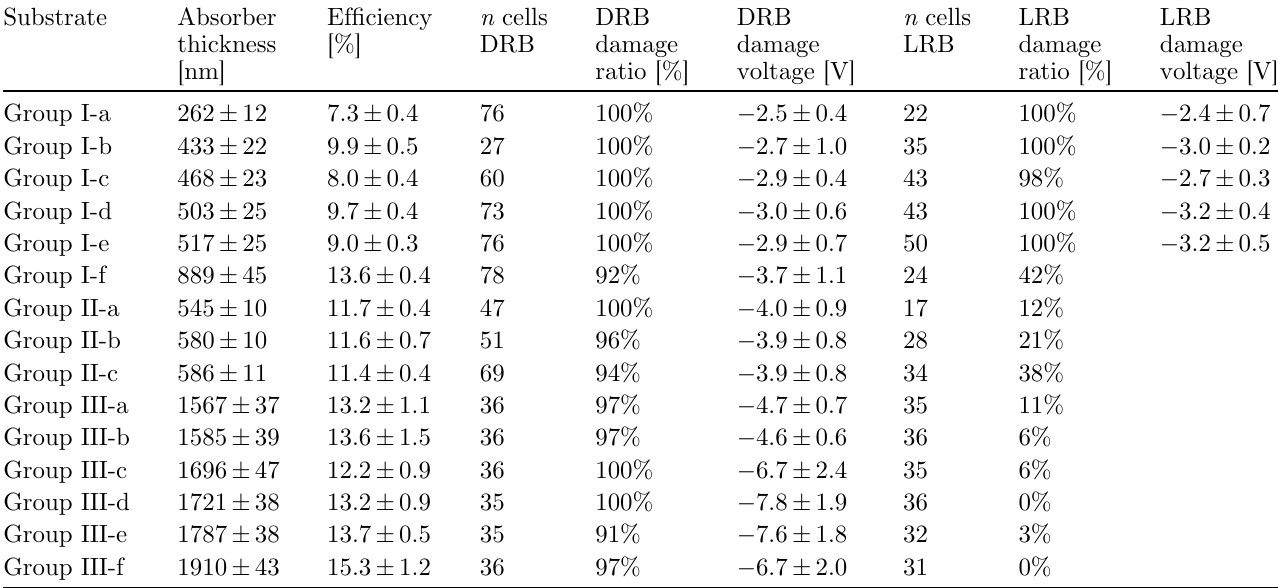
Table 1. List of substrates used including for each substrate the average absorber thickness, solar cell ef fi ciency, and damage voltage for both the dark (DRB) and illuminated (LRB) reverse bias sweeps. The average values are based on at least 22 measurement points per substrate, the error bar presented is the standard deviation. Several values are missing in the last column (damage voltage in LRB), due to the low number of damaged cells ( n < 20) needed to give a reliable estimate. The table also displays the damage ratio in both dark reverse bias and illuminated reverse bias, together with the number of cells ( n ) used to calculate this